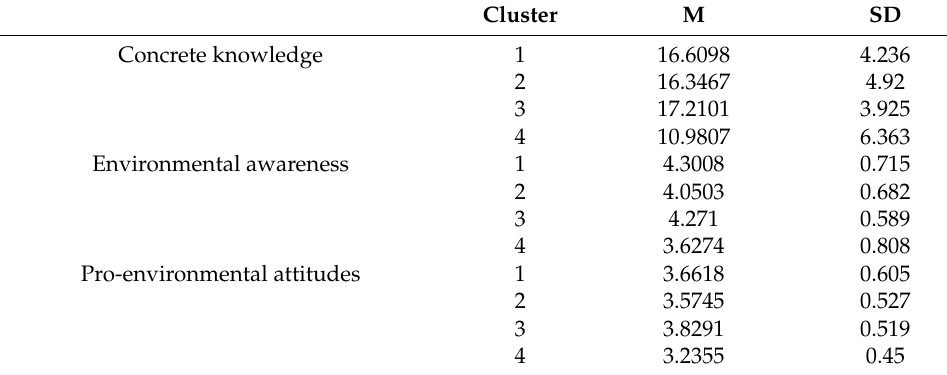
Table A3. Means and standard deviations of all SMEC variables for each